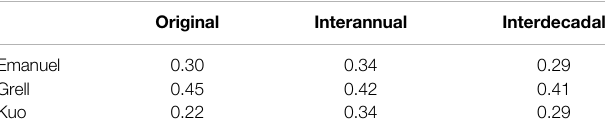
TABLE 3 | Spacial correlation coef fi cients between simulations and observations of Yangtze Meiyu averaged over the 55-year period (a) and its interannual (b) and interdecadal (c)